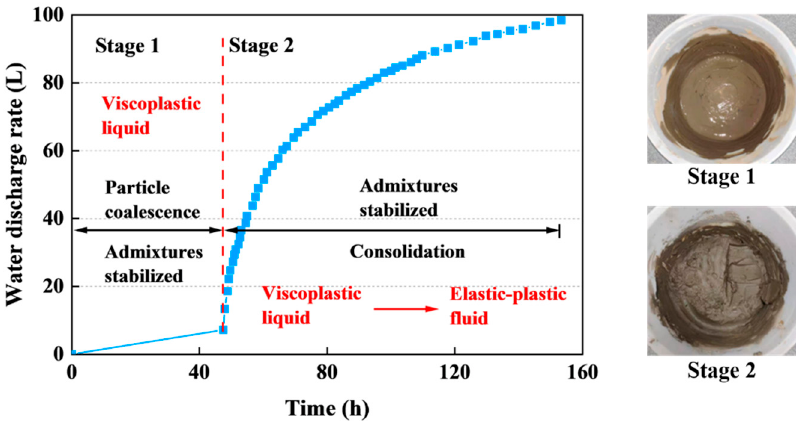
Figure 13. Physical and chemical reaction and phase change of state.